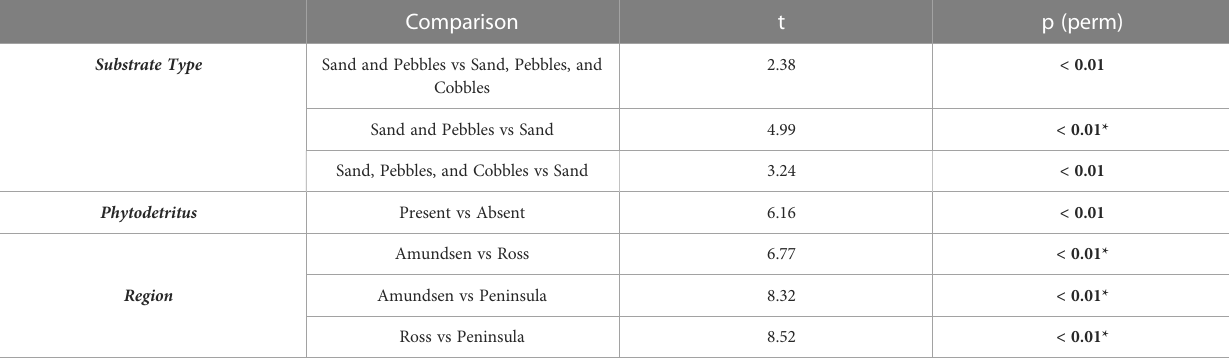
TABLE 3 PERMANOVA results (no. permutations: 9,999) to compare benthic communities revealing signi fi cant differences between substrate type and phytodetritus denoted by bold p values.